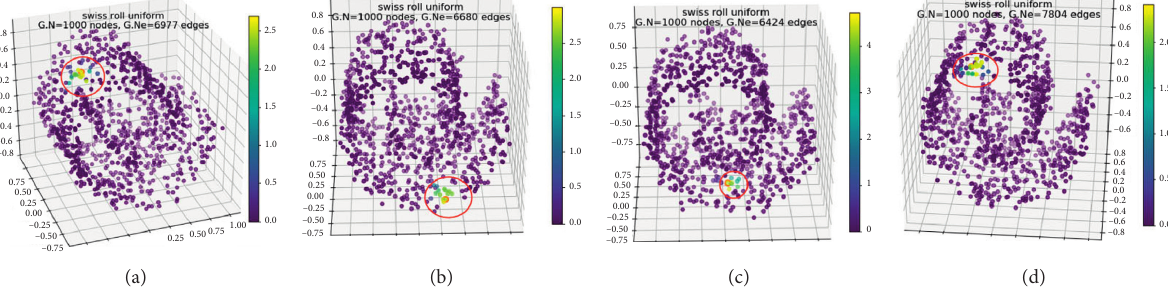
Figure 5: Graph spectral wavelet method used to determine the local range of anchor vector.